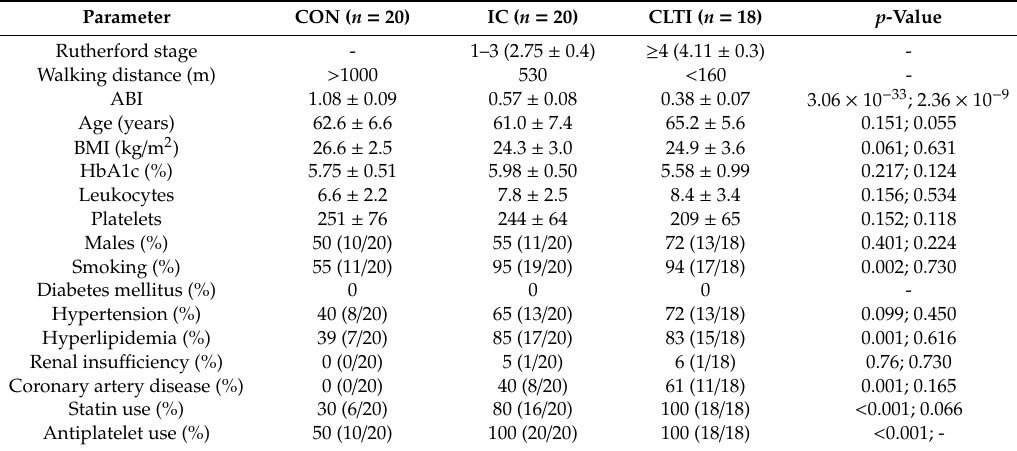
Table 1. Baseline patient demographics and clinical characteristics for two peripheral artery disease (PAD) sub-groups (intermittent claudication (IC), chronic limb-threatening ischemia (CLTI)) and non-PAD controls